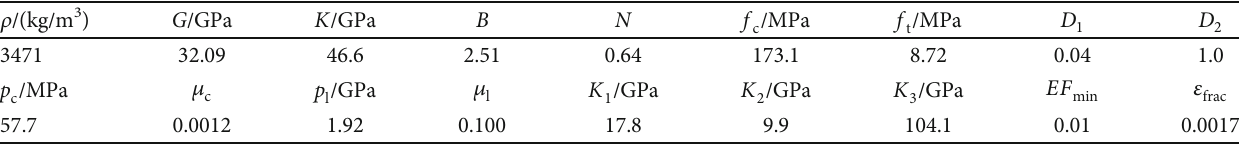
Table 1: Parameters of the modi fi ed HJC model.